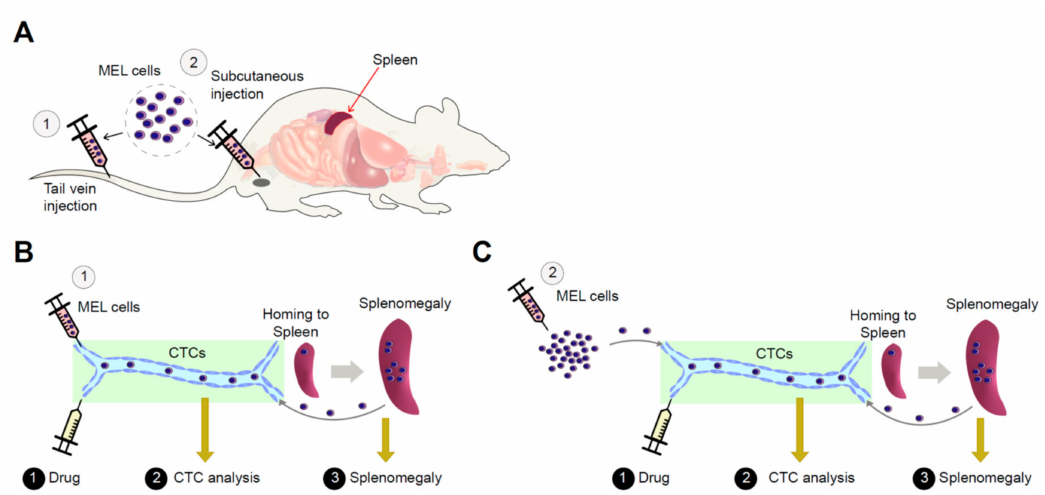
Figure 6. Schematic overview of established allograft model and its applicability for cancer researches. ( A ) Development of MEL cell-derived allograft model mice by 1 (cid:79) tail vein or 2 (cid:79) subcutaneous injection. Approaches to cancer detection, diagnosis and anti-cancer drug discovery by isolation and enrichment of MEL cells (CTC) with examination of splenomegaly in tail vein- ( B ) and subcutaneously-injected ( C ) MEL cell-derived allograft